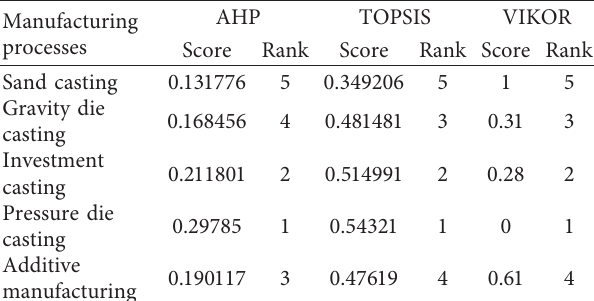
Table 14: Overall manufacturing process scores using AHP and